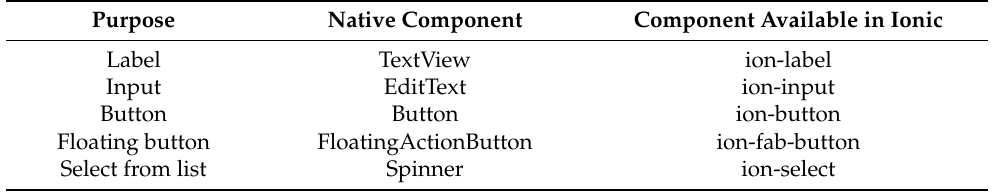
Table 7. User interface